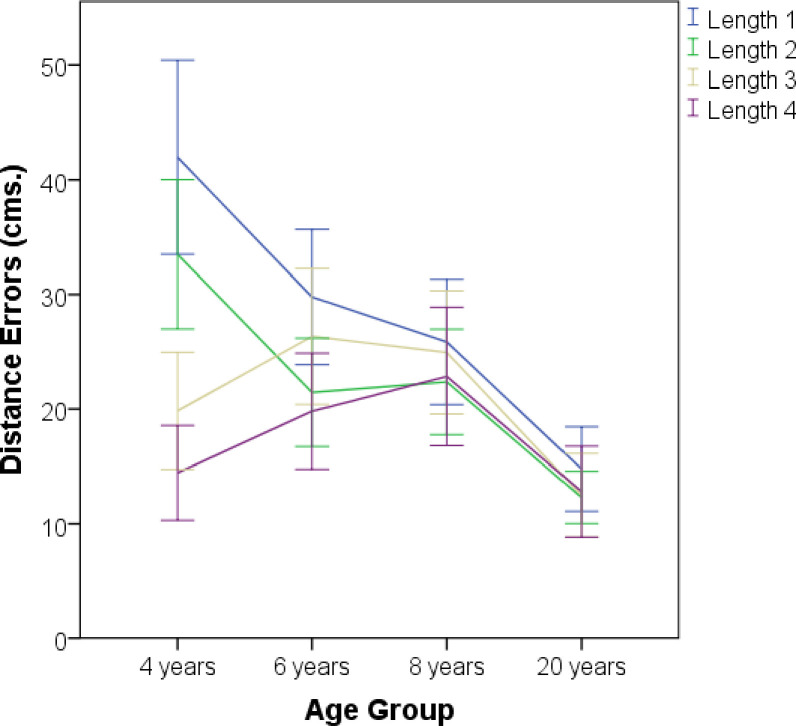
Mean error for distance.Error bars represent standard error of the mean.